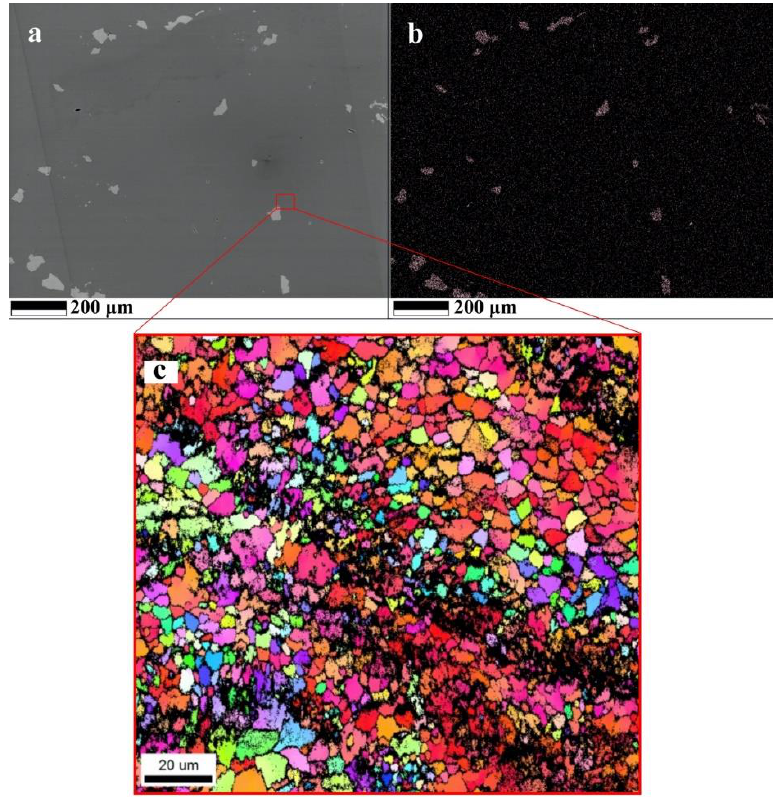
Figure 7. Images of AlSi10Mg/AlN composite polished surface ( a ), distribution of nitrogen ( b ), and EBSD map of a region near AlN particle ( c ).